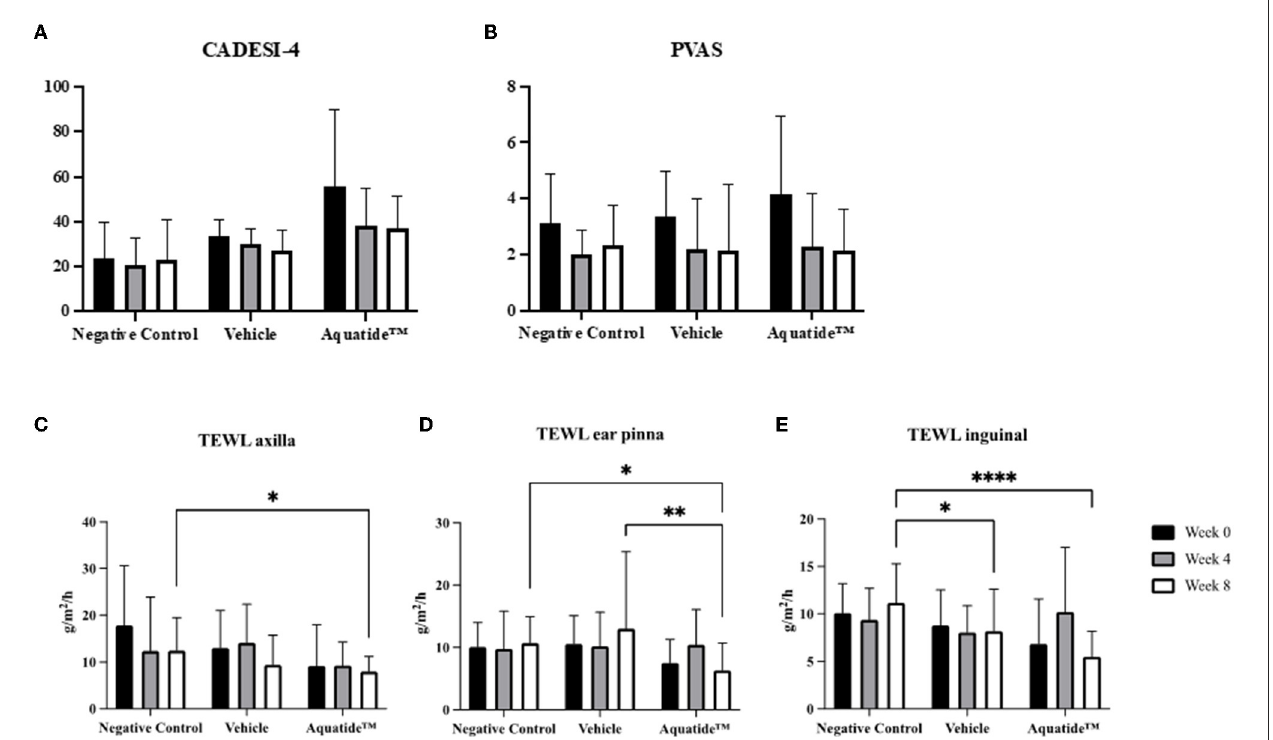
FIGURE3 Graphs of CADESI-4, PVAS and TEWL at week 0, 4, and 8 in the treatment group. Induction of autophagy significantly reduces TEWL in dogs with underlying diseases. CADESI-04, canine atopic dermatitis extent and severity index-04; VAS, visual analog scale; TEWL, transepidermal water loss. * p < 0.05, ** p < 0.01, and **** p <